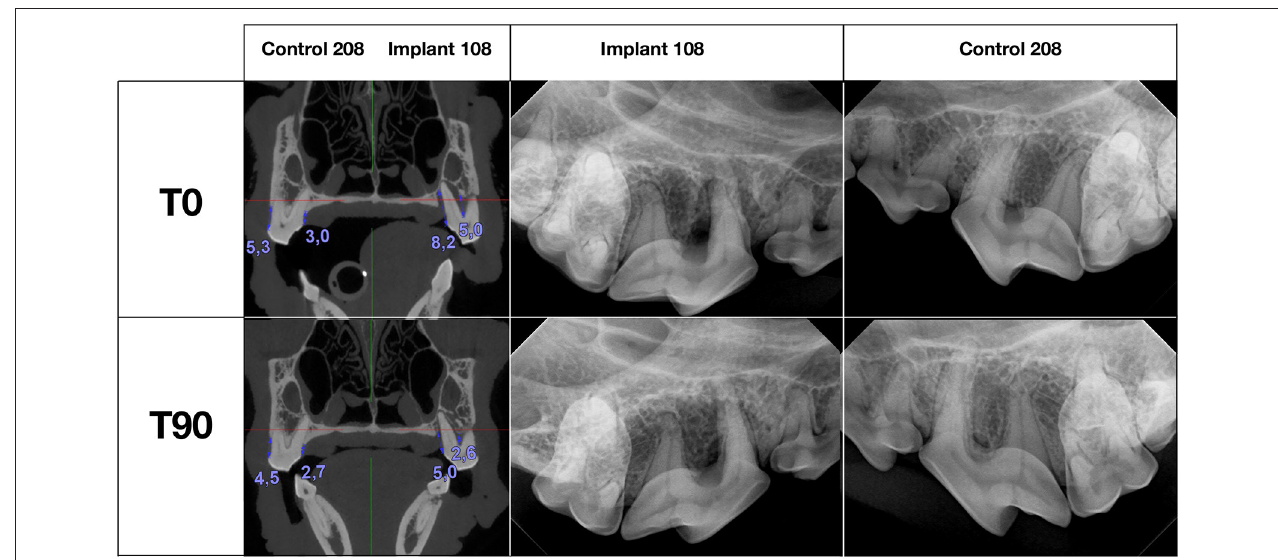
FIGURE 2 | Cone-beam computed tomography (CBCT) and radiographic findings at T0 and T90 in dog